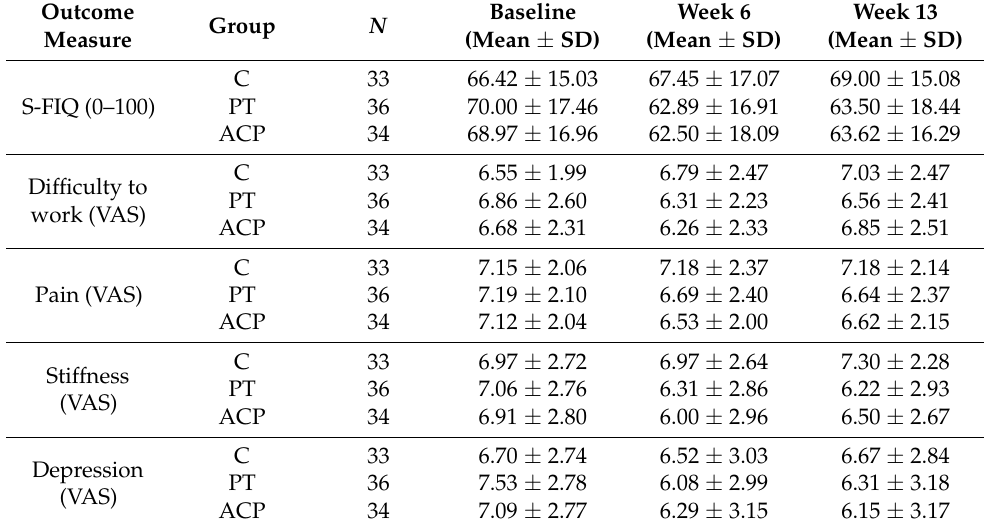
Table 2. Outcome scores for each group at baseline (week 0), post-intervention (week 6) and at follow-up (week 13): mean and standard deviation.